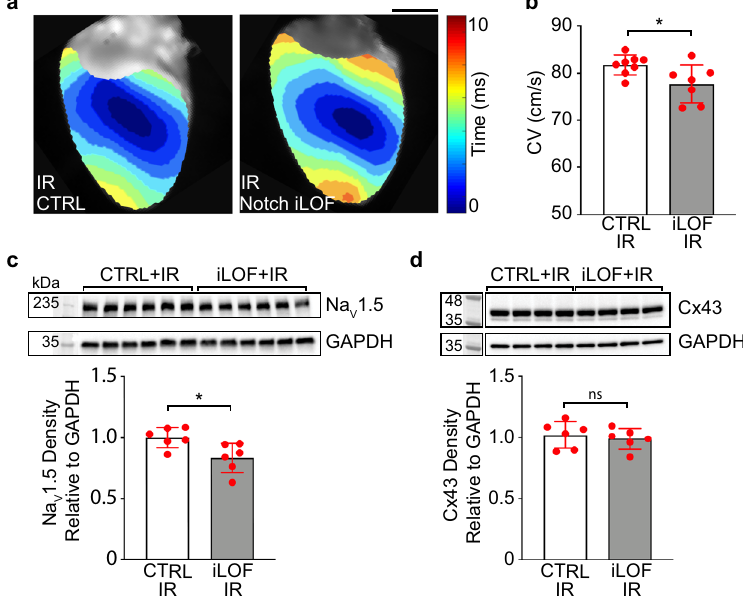
Fig. 7 Loss of cardiomyocyte Notch signaling inhibits radiation-induced conduction reprogramming. a Representative activation maps and b longitudinal conduction velocity measurements of irradiated littermate control (left, CTRL, white bars) and α MHC-MerCreMer ; R26r dnMAML/ + (right, iLOF, gray bars) murine hearts at 6 weeks post-IR. n = 8 biologically independent CTRL mice; n = 7 biologically independent iLOF mice ; * P = 0.027. c , d Western blot and quanti fi ed densitometry of Na V 1.5 ( n = 6 biologically independent samples per condition, * P = 0.012) and Cx43 ( n = 6 biologically independent samples per condition across two blots run in parallel, P = 0.59,). All P values determined by two-way unpaired t test. All bar graphs are represented as mean ± SD. Source data are provided as a Source data fi